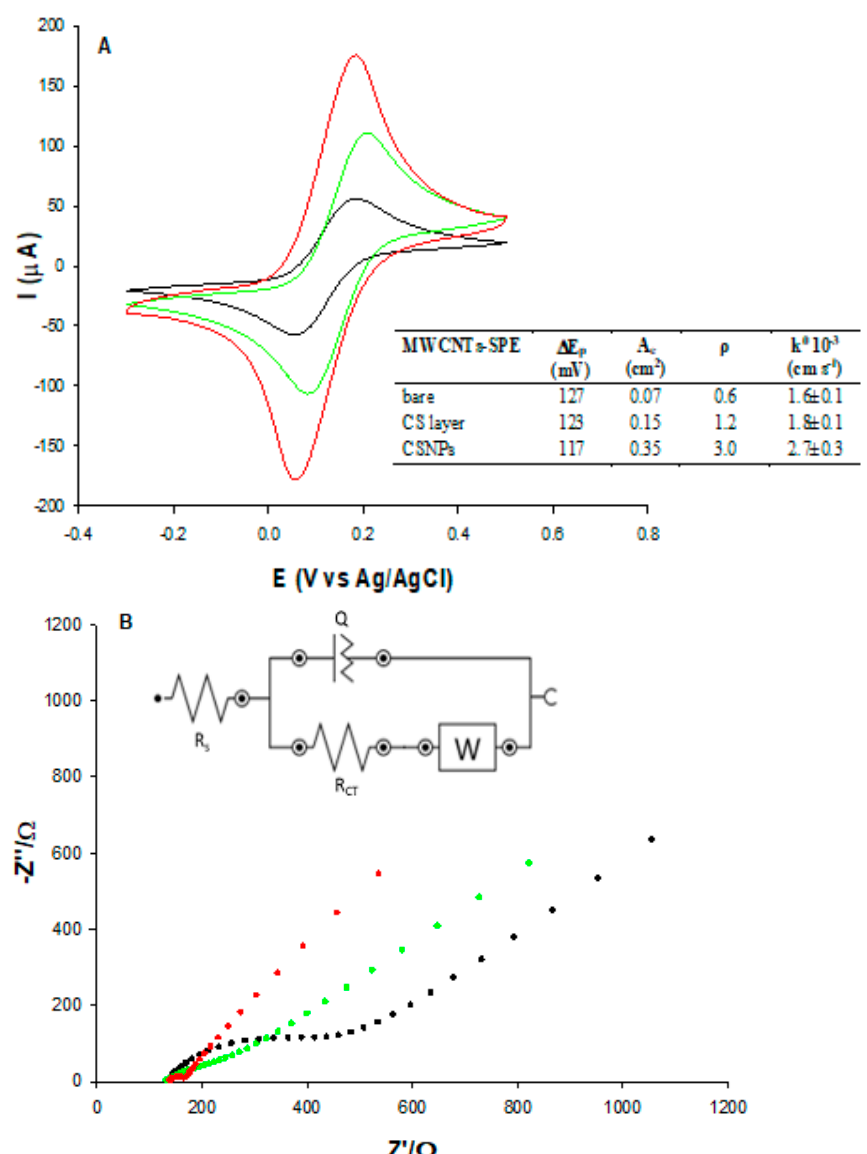
Figure 3. ( A ) CVs and ( B ) Nyquist plots of MWCNTs (black), MWCNTs-CS layer (green), and MWCNT-CSNPs (red) SPEs, measured in Zobell’s solution. Inset: simple Randles circuit.